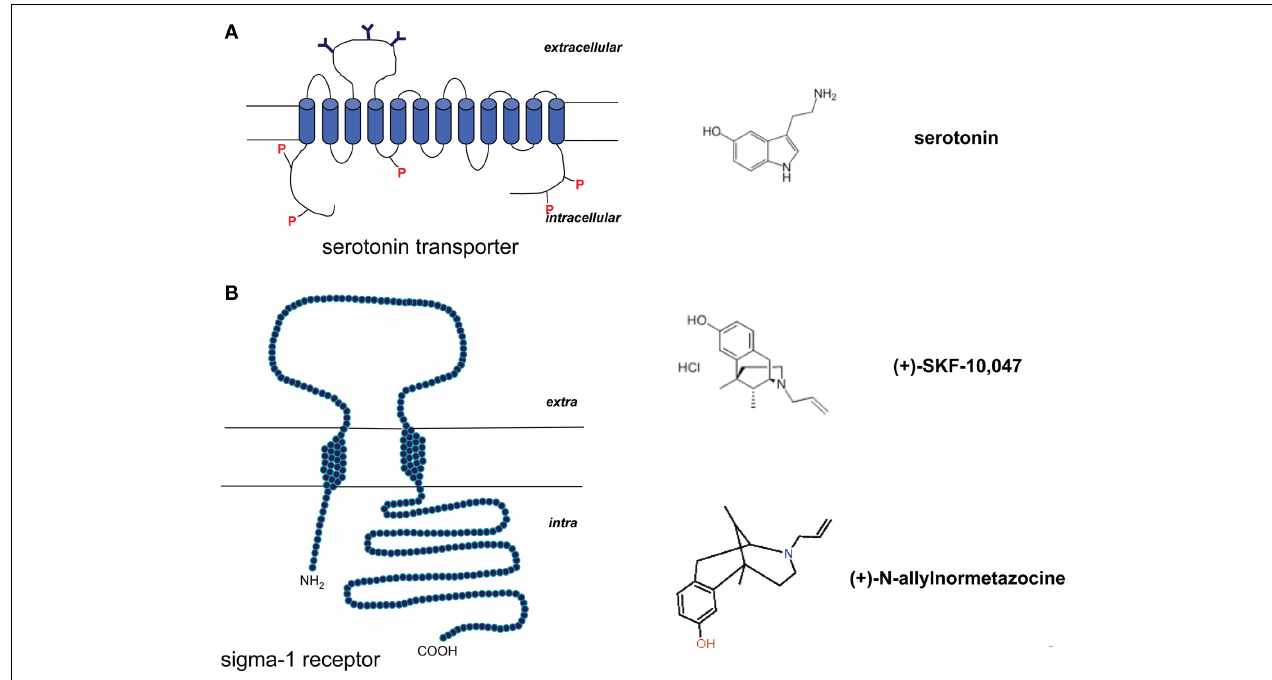
FIGURE 2 | (A) Schematic model of the serotonin transporter and the molecule structure of serotonin (5-HT). (B) Schematic model of the sigma-1 receptor and molecule structure of the sigma-1 agonists ( + )- N -allylnormetazocine and ( +